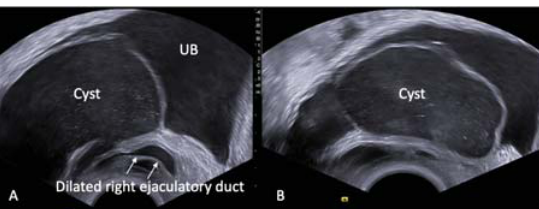
Figure 1. Transabdominal sonography images. Empty right renal fossa (A); Large right paramedian pelvic cyst protruding into the bladder (B). also noted extending from the L4 vertebral level down to (cid:87)(cid:75)(cid:72)(cid:3)(cid:70)(cid:92)(cid:86)(cid:87)(cid:76)(cid:70)(cid:3)(cid:86)(cid:87)(cid:85)(cid:88)(cid:70)(cid:87)(cid:88)(cid:85)(cid:72)(cid:3)(cid:76)(cid:81)(cid:3)(cid:87)(cid:75)(cid:72)(cid:3)(cid:83)(cid:72)(cid:79)(cid:89)(cid:76)(cid:86)(cid:3)(cid:11) Figure 2 (cid:12)(cid:17)(cid:3)(cid:55)(cid:82)(cid:3)(cid:70)(cid:82)(cid:81)(cid:191)(cid:85)(cid:80)(cid:3)(cid:87)(cid:75)(cid:76)(cid:86)(cid:15)(cid:3) (cid:90)(cid:72)(cid:3) (cid:83)(cid:72)(cid:85)(cid:73)(cid:82)(cid:85)(cid:80)(cid:72)(cid:71)(cid:3) (cid:87)(cid:75)(cid:72)(cid:3) (cid:87)(cid:85)(cid:68)(cid:81)(cid:86)(cid:85)(cid:72)(cid:70)(cid:87)(cid:68)(cid:79)(cid:3) (cid:88)(cid:79)(cid:87)(cid:85)(cid:68)(cid:86)(cid:82)(cid:88)(cid:81)(cid:71)(cid:3) (cid:11)(cid:55)(cid:53)(cid:56)(cid:54)(cid:12)(cid:3) (cid:90)(cid:75)(cid:76)(cid:70)(cid:75)(cid:3) demonstrated dilated right ejaculatory duct, which was contiguous with the cystically dilated right seminal vesicle. Dilated right ureter was also communicating with dilated right seminal vesicle. Cystically dilated portion of right seminal vesicle was protruding into the bladder lumen. The cystic structure showed internal echoes as well, probably